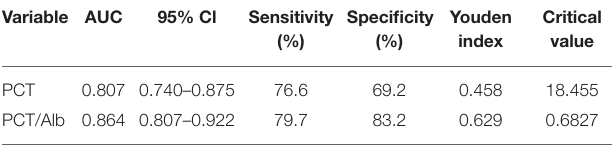
TABLE 4 | PCT, PCT/Alb, CRP, and CRP/Alb were analyzed by the ROC curve.